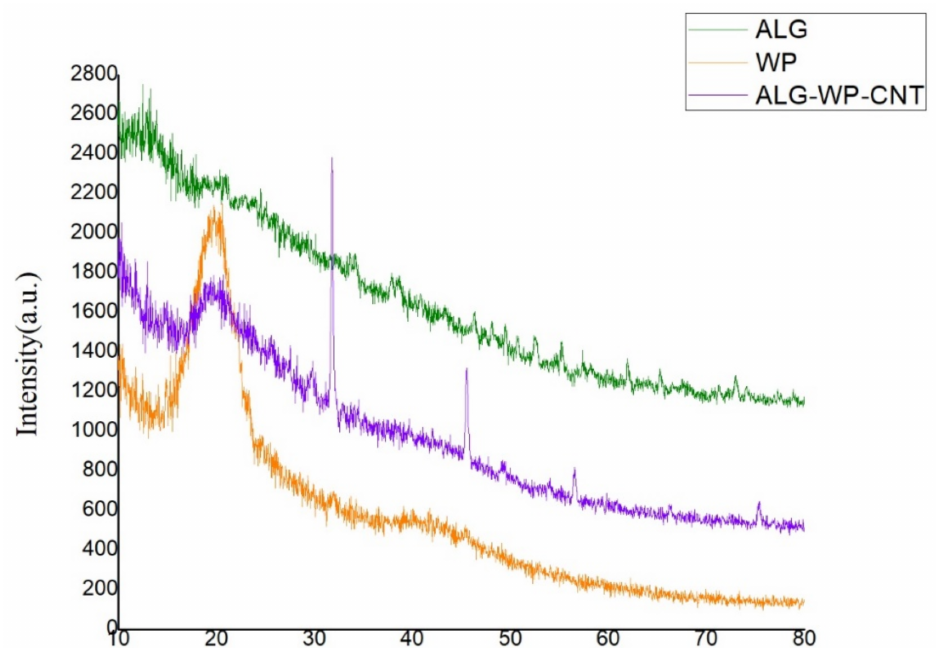
Figure 2. XRD patterns of sodium alginate (ALG), whey protein (WP), and ALG–WP–CNT micro- capsules. Adapted from [5].